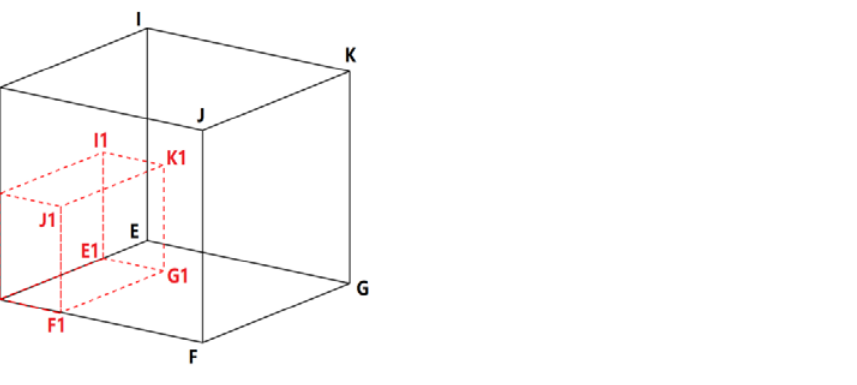
Figure 4. Schematic diagram of socio-economic development index (SDI) model.